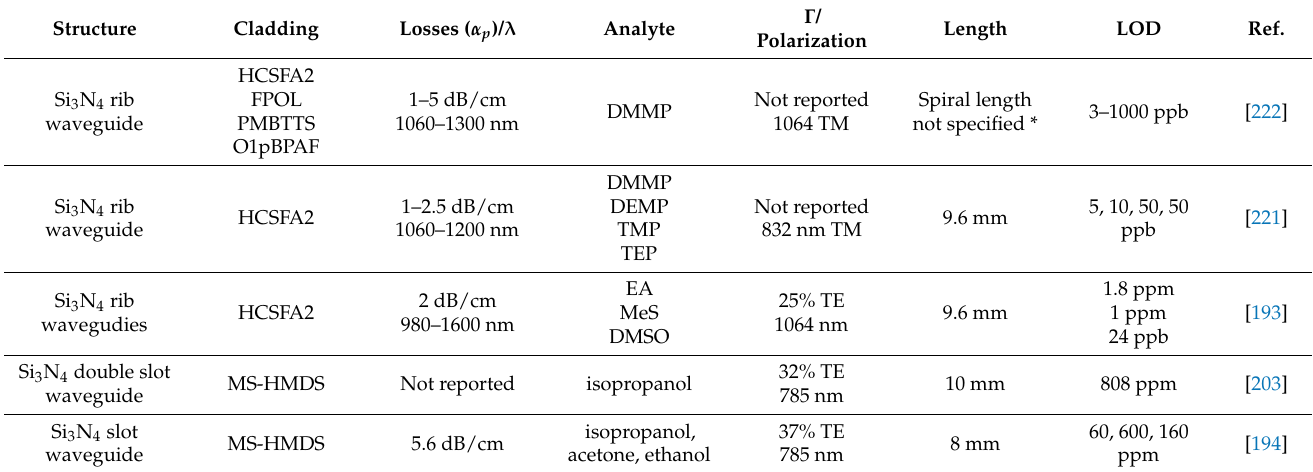
Figure 5. Examples of WERS spectra. Experimental Raman spectrum after background subtraction for vapors absorbed in the cladding (HCSFA2 ( a , b ), Ms-HMDS ( c , d )). In each plot, the reference spectrum is placed above the experimental one, and the selected peak used to track different concentrations is shown to the right. Reproduced with permission from reference [193], © 2021, Optical Society of America, and reference [194], © 2021, Optical Society of America. Table 2. Overview of works using clad waveguides for